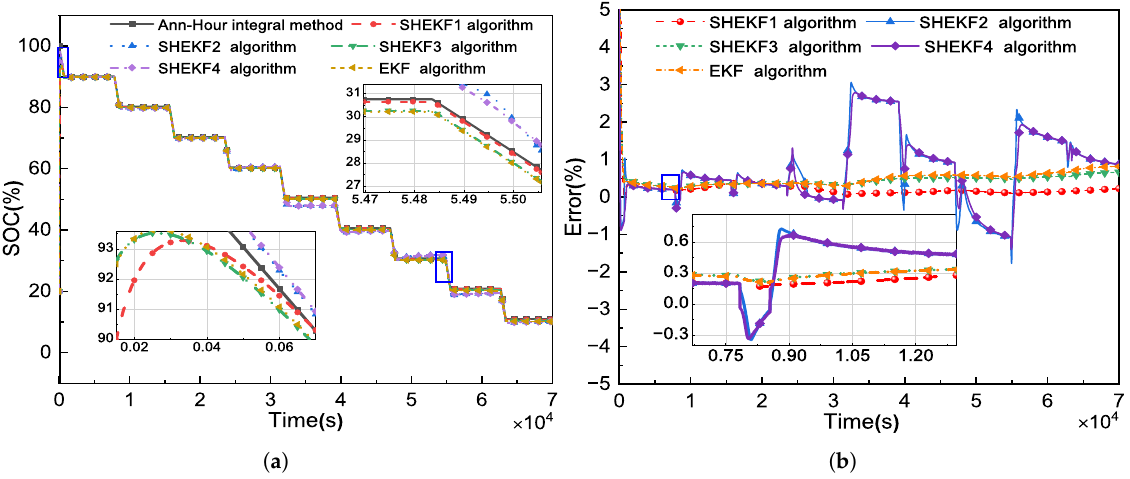
Figure 10. Algorithms comparison and its error curve with incorrect SOC initial value: ( a ) SOC with the initial value of SOC is 0.2, ( b ) Error with the initial value of SOC is